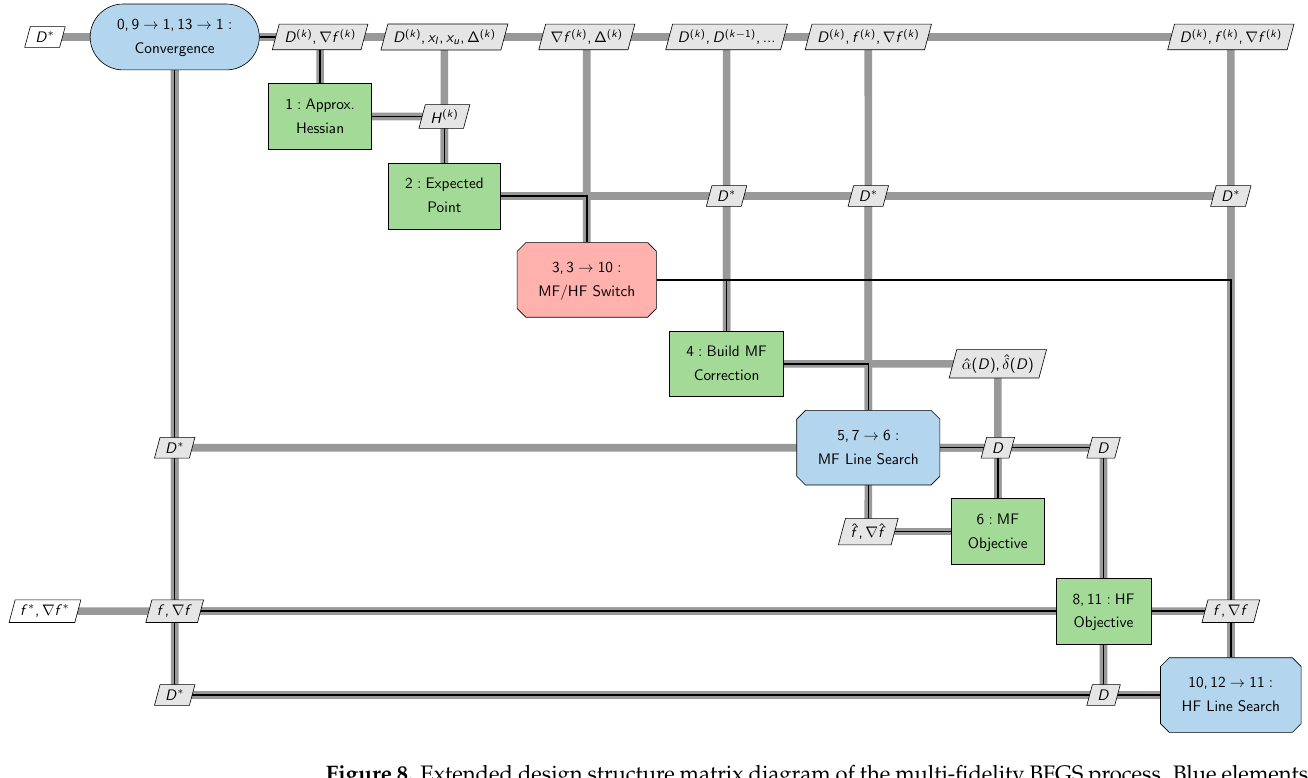
Figure 8. Extended design structure matrix diagram of the multi-fidelity BFGS process. Blue elements represent iterative processes (i.e., optimization convergence or line searching); red represents the fidelity switching decision; green represents the calculation of values involved in the optimization